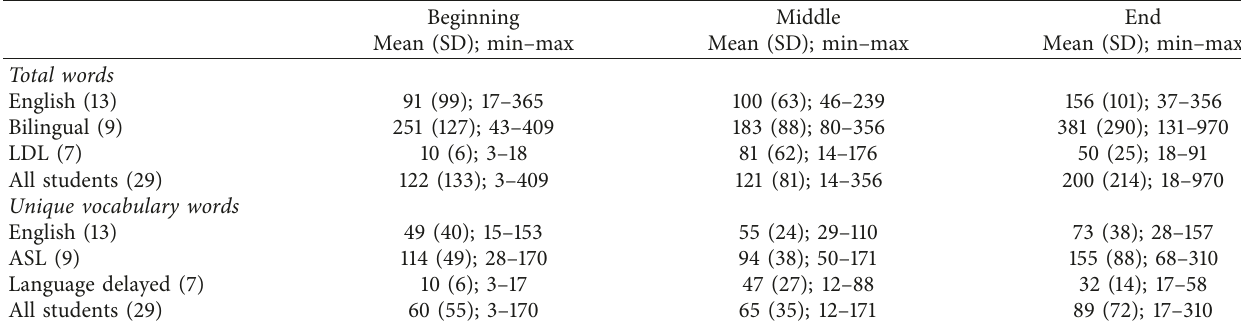
Table 5: Mean, standard deviation (SD), and minimum and maximum for total number of words and unique vocabulary words for the beginning, middle, and end of the year writing samples by language